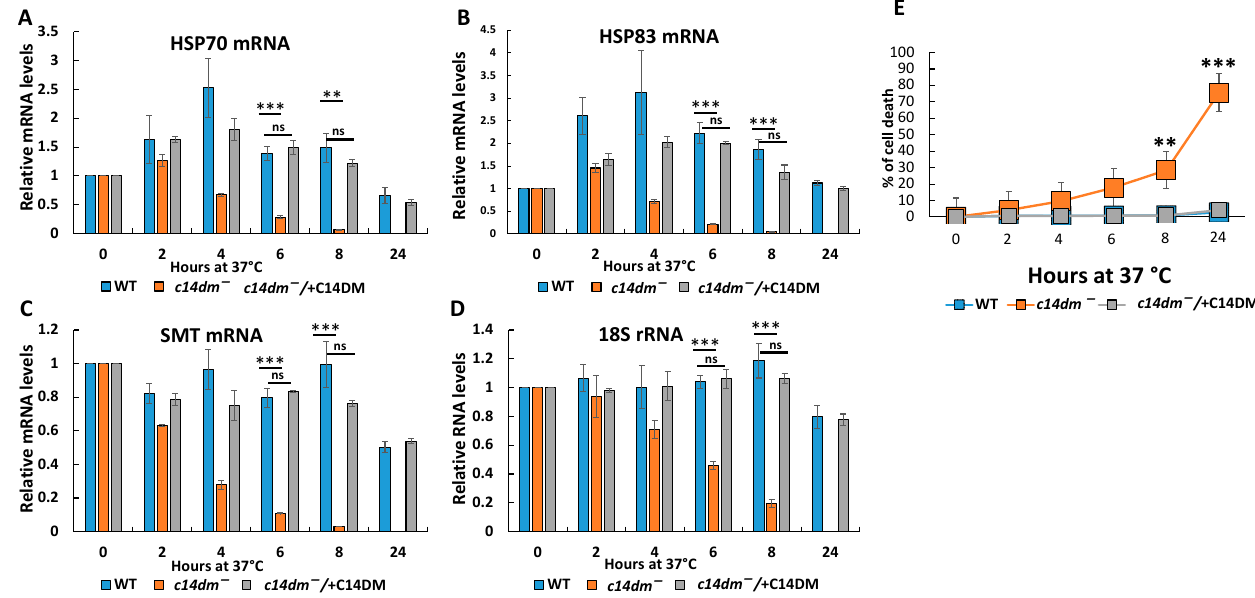
Figure 4. C14dm – mutants show a dramatic decrease in RNA levels during heat shock. Promastigotes were incubated at 37 °C for 0–24 h, and cells were collected and analyzed at the indicated times. Artificial OmpA mRNA was added prior to RNA extraction for normalization. HSP70 ( A ), HSP83 ( B ), SMT ( C ) mRNA and 18S rRNA ( D ) levels were measured by RT-qPCR. ( E ) Cell viability was monitored by PI staining during heat shock. ns: not significant; **: p < 0.01; and ***: p < 0.001.